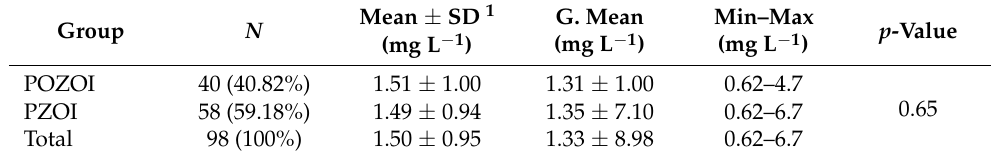
Table 3. Non-parametric Mann–Whitney test for urinary 1-OHP levels in study populations. Group N